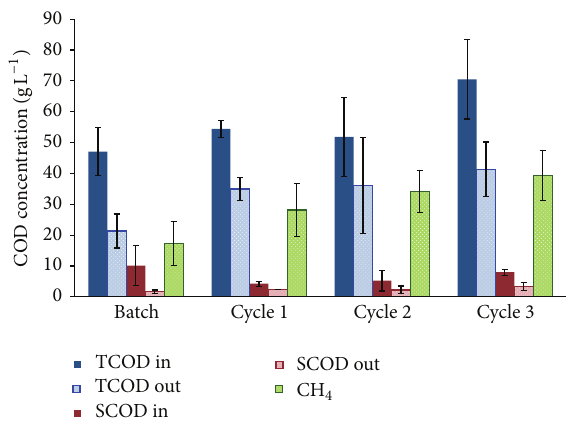
Figure 1: Total COD (TCOD) and soluble COD (SCOD) in the influent and effluent of the reactor and the COD content of the total methane (CH 4 ) produced during each operating phase (batch and 3 cycles of semicontinuous operation). The data are averages with standard deviations of three or more